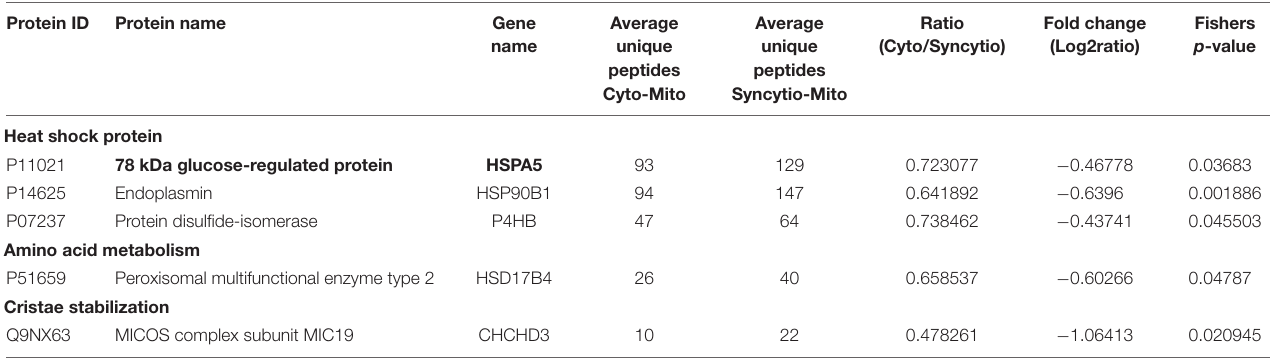
TABLE 2 | Proteomic analysis of isolated mitochondria from the cytotrophoblast and syncytiotrophoblast cell lineages of the placenta which were expressed significantly greater in syncytiotrophoblast mitochondria. Protein